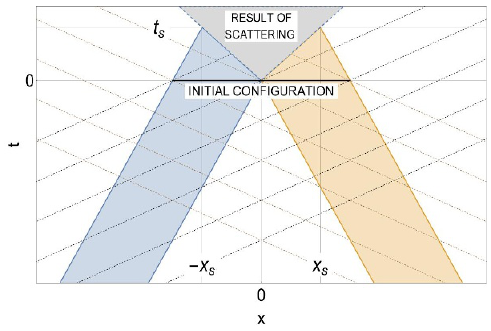
Figure 16 . Worldsheets of two incoming oscillons for v = 0. The oscillons are unperturbed inside two triangular regions above the line t = 0. The zeros of the oscillon correspond to the intersections of its worldsheet with a family of dashed